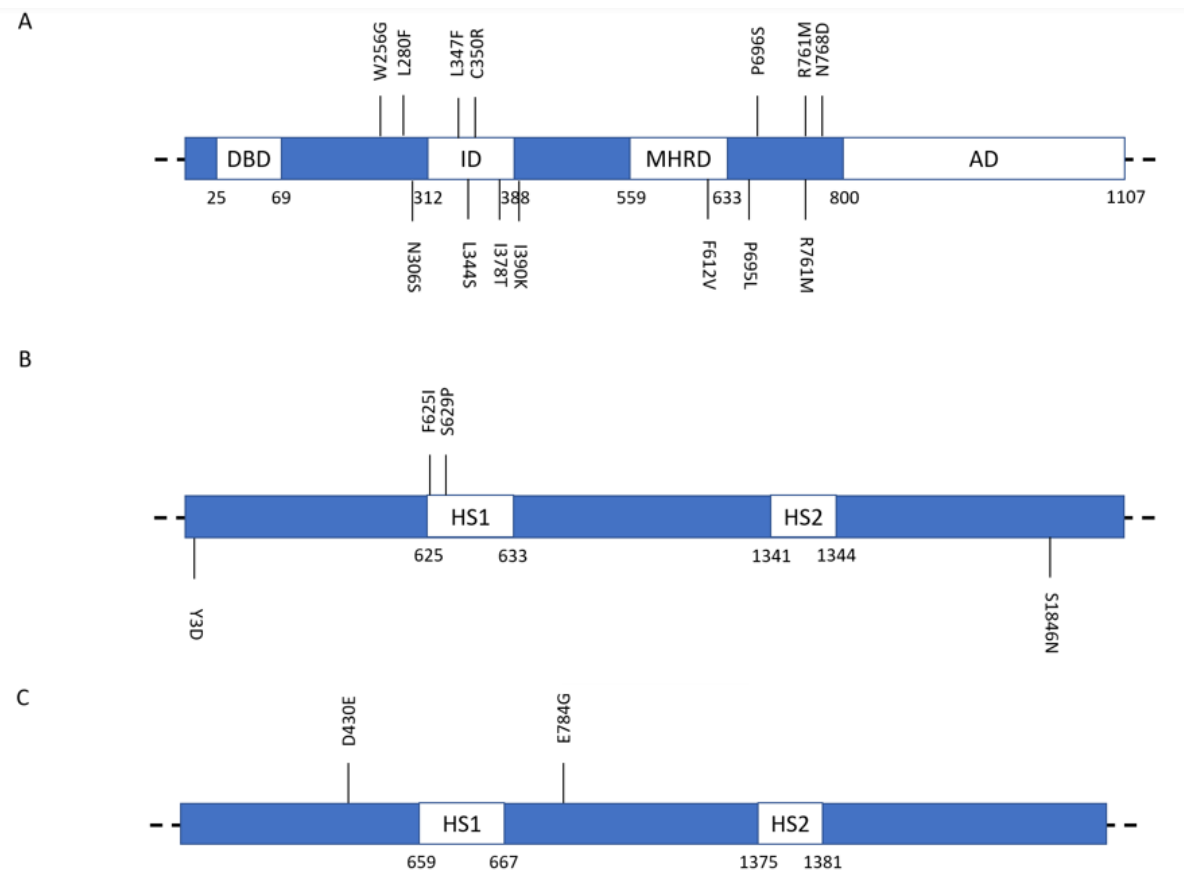
FIGURE 4: Representation of the variants found in resistance genes typically subjected to mutations conferring resistance to azoles or echinocandins. Protein domains are represented to provide visual illustration of the variants position in the protein context. (A) Upper muta- tions – PDR1 variants identified in the genomes of azole resistant isolates but not in the genomes of susceptible isolates; Bottom mutations – PDR1 variants identified in the genomes of multi resistant isolates but not in the genomes of susceptible isolates. (B) Upper mutations – FKS1 variants identified in the genomes of echinocandin resistant isolates but not in the genomes of susceptible isolates; Bottom mutations – FKS1 variants identified in the genomes of multi resistant isolates but not in the genomes of susceptible isolates. (C) FKS2 variants identified in the genomes of echinocandin resistant isolates but not in the genomes of susceptible isolates. DBD – DNA Binding Domain, ID – Inhibitory Do- main, MHRD – Middle Homology Regulatory Domain, AD – Activation Domain, HS1 – Hotspot 1, HS2 – Hotspot